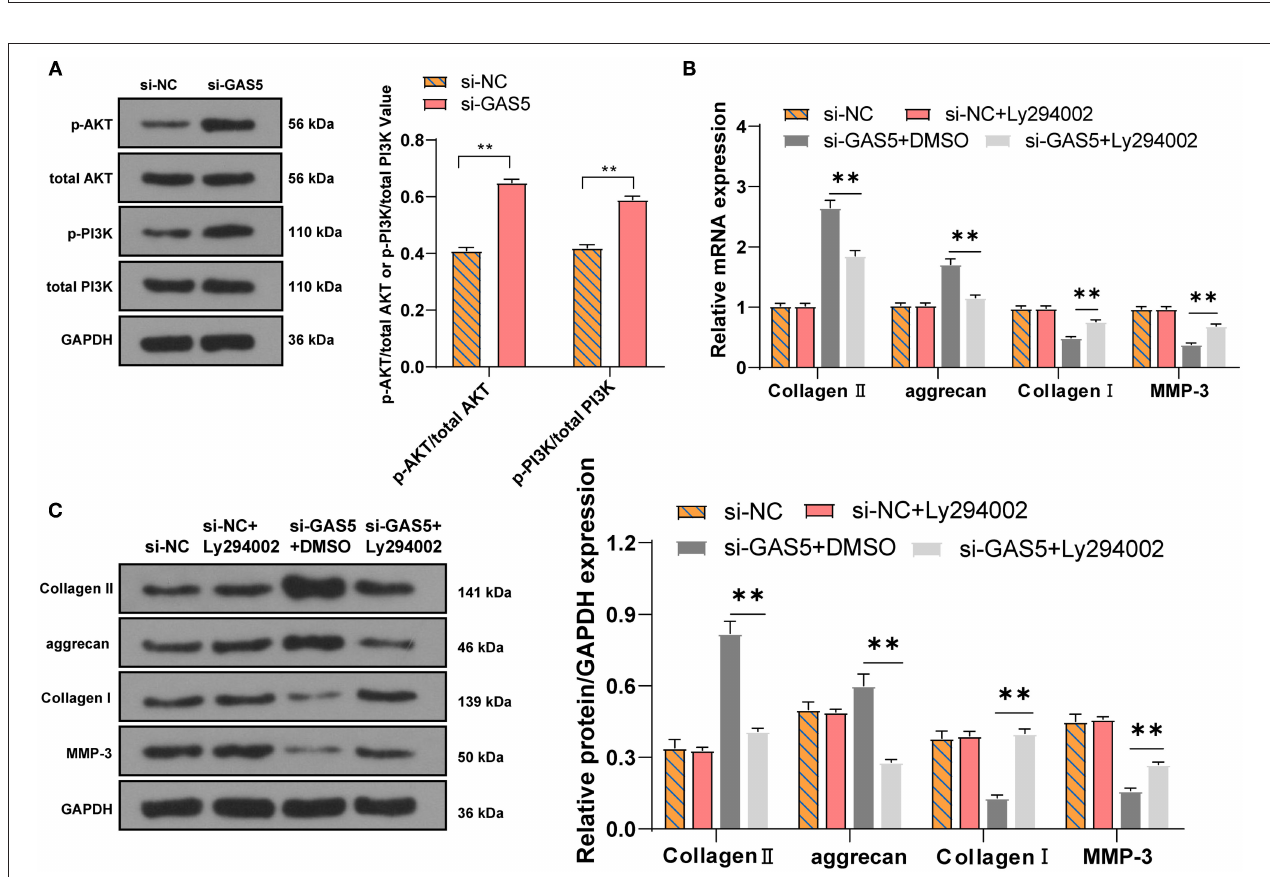
FIGURE 5 | LncRNA GAS5/miR-26a-5p/PTEN regulates the ECM synthesis of degenerative NPCs via the PI3K/Akt pathway. (A) The protein levels of PI3K/Akt in degenerative NPCs with low expression of GAS5 were detected by Western blot; the PI3K/Akt inhibitor LY294002 was added to degenerative NPCs with low expression of GAS5, and si-GAS5 + DMSO was used as control. (B,C) RT-qPCR and Western blot were used to detect the level of ECM-related genes. The cell experiment was repeated three times, and the data were expressed as mean ± standard deviation; independent t -test was used for comparison between two groups in (A) while one-way ANOVA was used for comparison among multiple groups in (B,C) , followed by Tukey’s multiple comparisons test. ** p < 0.01.